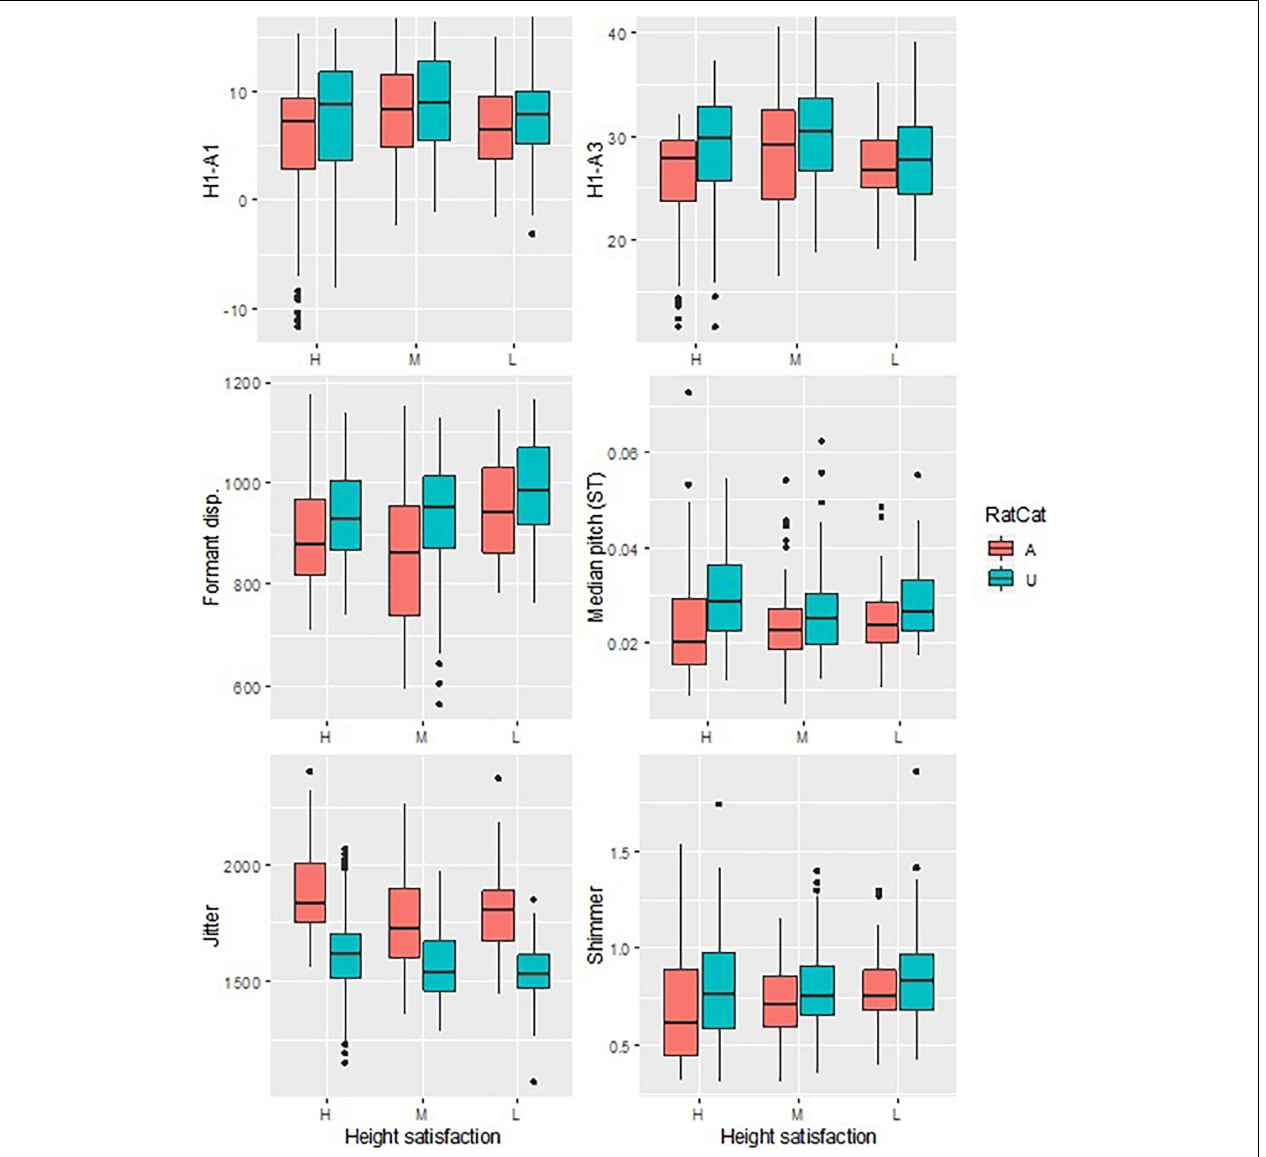
FIGURE 1 | Boxplots comparing acoustic correlates of projected voices in attractive (A) vs. unattractive (U) facial stimulus conditions. H, M, L stand for highly, moderately, least satisfied with speakers’ own height.